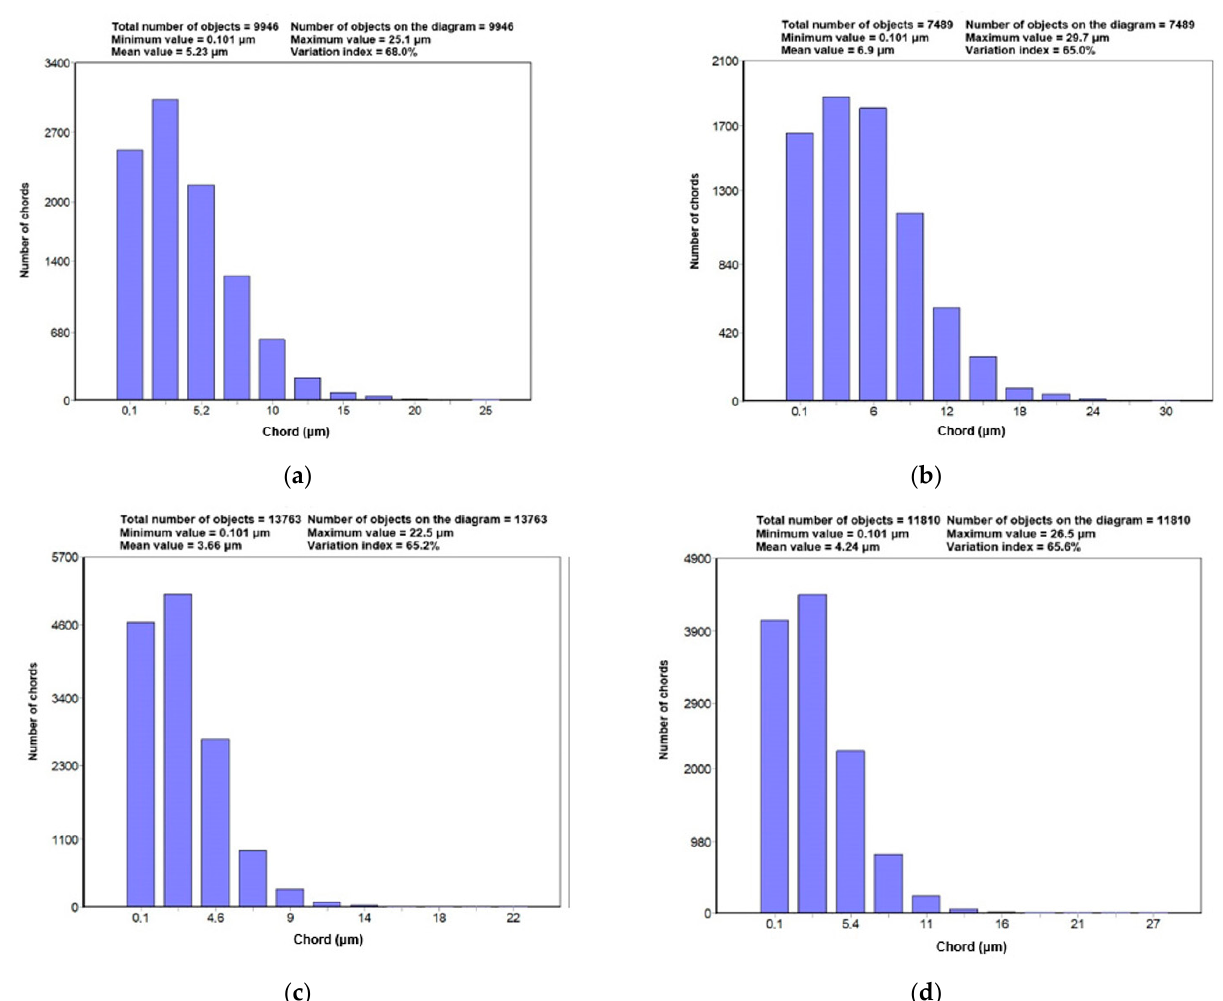
Figure 8. Diagrams of statistical distributions of chord lengths intersecting WC grains in particular tips: ( a ) Longwall 1 tip, ( b ) Road 1 tip, ( c ) Longwall 2 tip, ( d ) Road 2 tip.